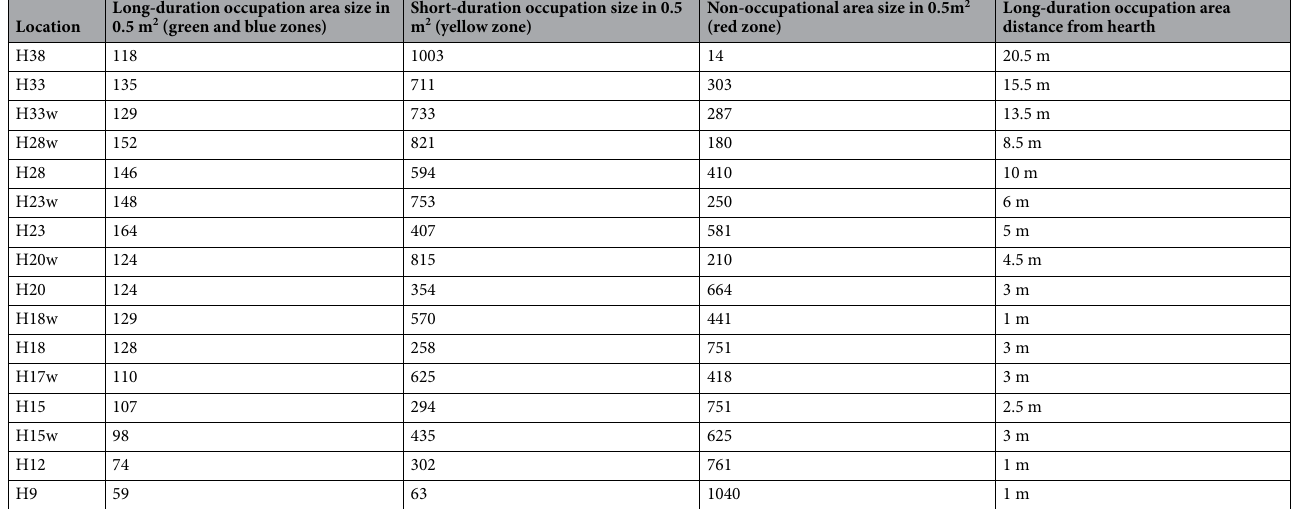
Table 3. Results for smoke density from sensors at 0.5 m